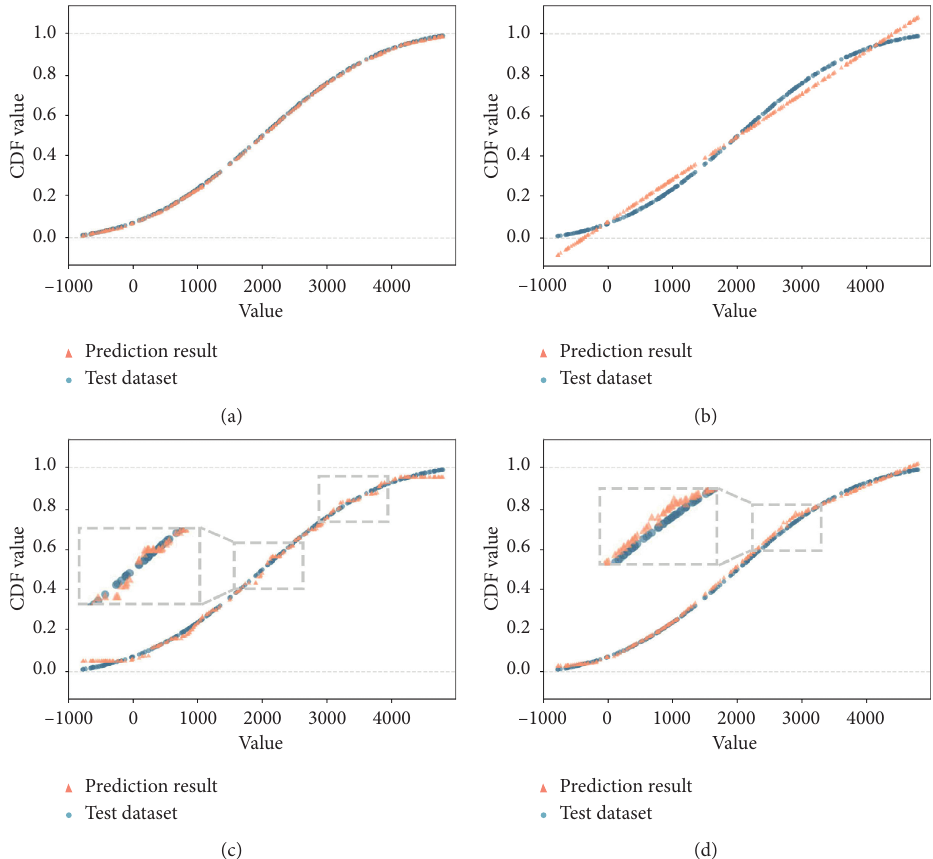
Figure 9: Illustration of some experimental results. In all charts, the x -axis represents the values of unsorted elements in the test dataset and the y -axis represents their CDF values. All charts are drawn based on the same dataset in normal distribution with a 1 million scale. The pink triangle-shaped points depict the CDF values predicted by predictive models, the blue points present the true CDF values of unsorted elements in test datasets, and the lower and upper gray lines are the lower and upper bounds of the CDF (i.e., 0 and 1), respectively. (a) LNN model, (b) LR model, (c) Ada Boost model, and (d) DNN model. Table 2: Average time consumptions of five sorting algorithms on five experimental data sizes (in seconds). Data